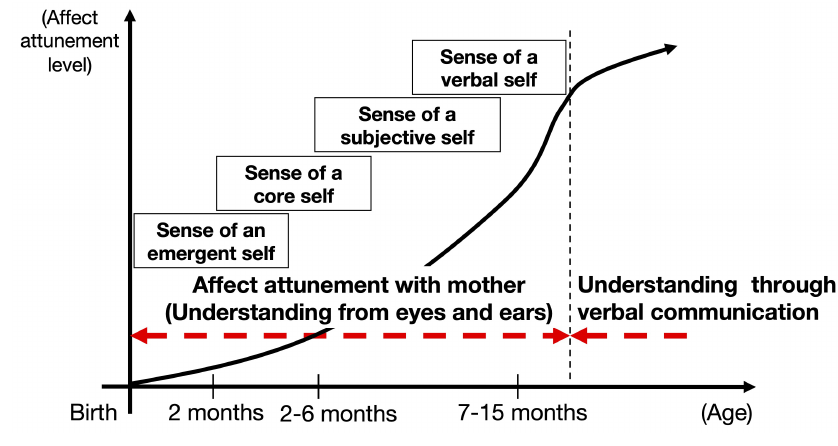
Figure 20. Infant development process